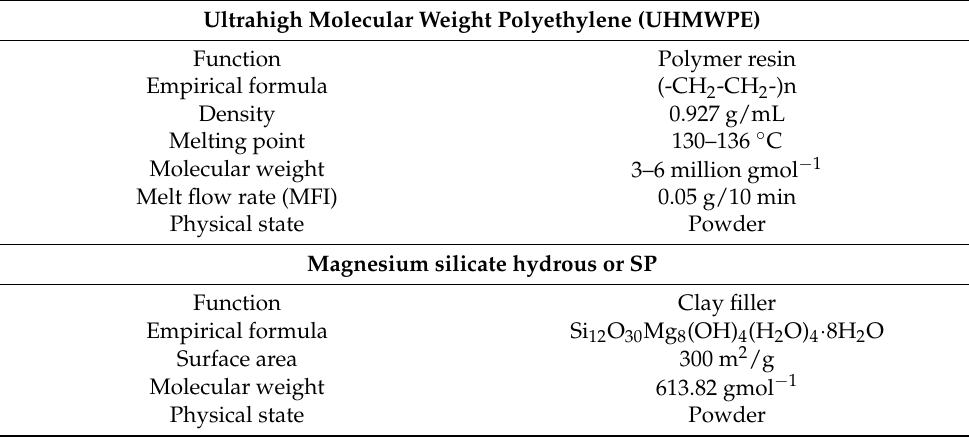
Table 1. Notable properties of UHMWPE and